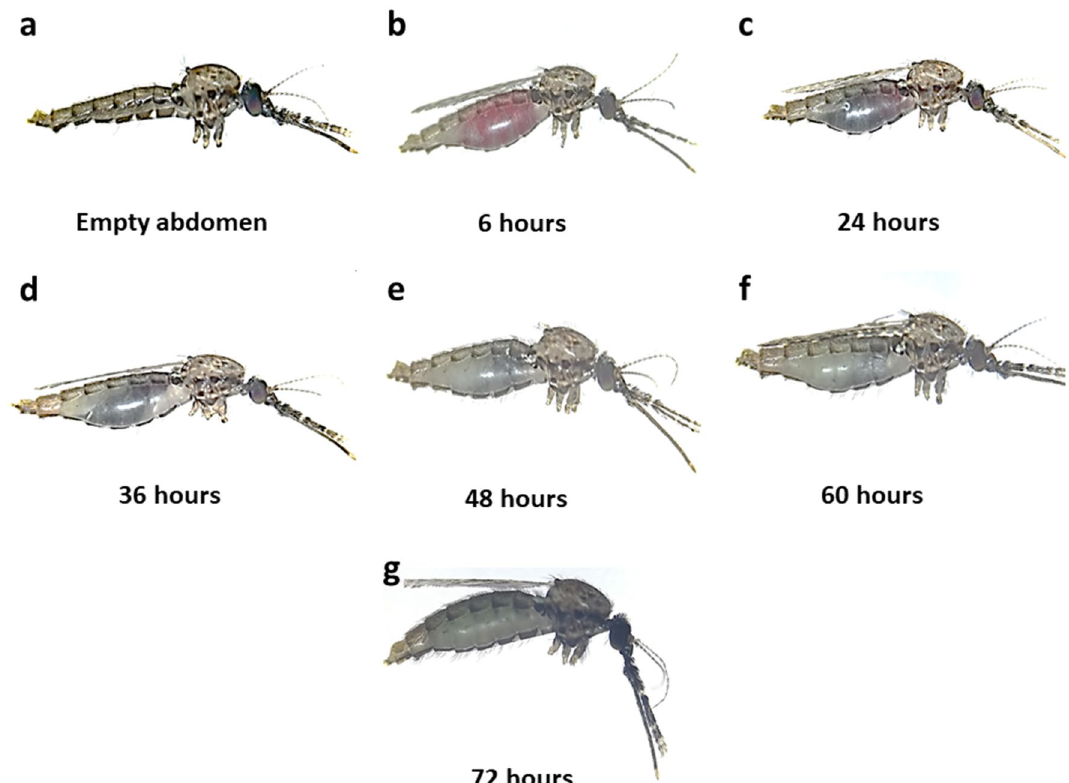
Figure 3. Females Anopheles cracens mosquitoes at different degrees of digestion based on the 7 stages of Sella scale: ( a ) Mosquito with empty stomach without blood and ovaries undeveloped; ( b ) Mosquito completely engorged with fresh blood that appeared bright red in colour with ovaries not developed at 6 h after blood meal; ( c ) Partially engorged where the anterior region of 5½–6 sternites and 3–4 tergites are occupied with dark blood at 24 h after blood meal; ( d ) Blood in the stomach appeared very dark which occupied the anterior region of 5–5½ sternites and 2–3 tergites at 36 h after blood meal; ( e ) The blood in the stomach appeared black and occupied the anterior region of 4½–5½ sternites and ½–1½ tergites at 48 h after blood meal; ( f ) The blood in the stomach appeared black and is only visible on the ventral side whereas the rest of the abdomen is filled with developing eggs at 60 h after blood meal; ( g ) Abdomen full with eggs with no visible blood at 72 h after blood